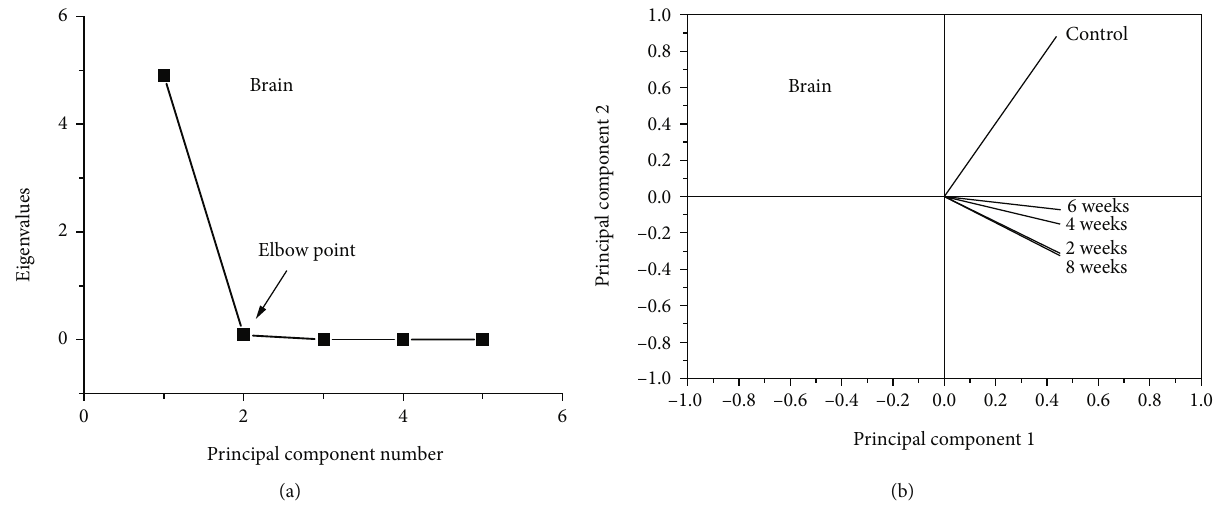
Figure 6: (a) Eigenvalues in relation to the principal components of FTIR data and (b) the loading plot of PCA for brain amide I FTIR assignments: β -turn ( 1675 ± 2 and 1667 ± 2 cm -1 ), α -helix ( 1659 ± 2 , 1650 ± 2 , and 1643 ± 1 cm -1 ), and β -sheet ( 1635 ± 2 cm -1 ).